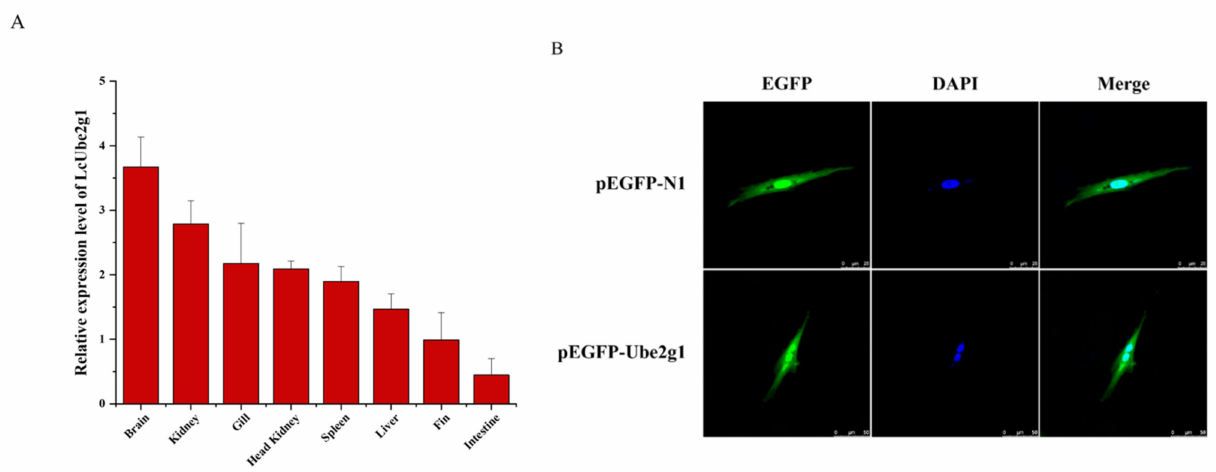
Figure 3. LcUbe2g1 tissue expression profile and the subcellular localization of Lc UBE2G1. ( A ) Rel- ative transcript levels of LcUbe2g1 in different tissues. RT-qPCR was performed to determine the relative expression of LcUbe2g1 in different tissues of Larimichthys crocea , including brain, kidney, gills, head kidney, spleen, liver, fins and intestine. β -actin was used as an internal control to normalize the expression level; ( B ) Subcellular localization of Lc UBE2G1 protein in transfected Larimichthys crocea head kidney cells. The images were captured under confocal fluorescence microscopy. Scale bar = 50 µ